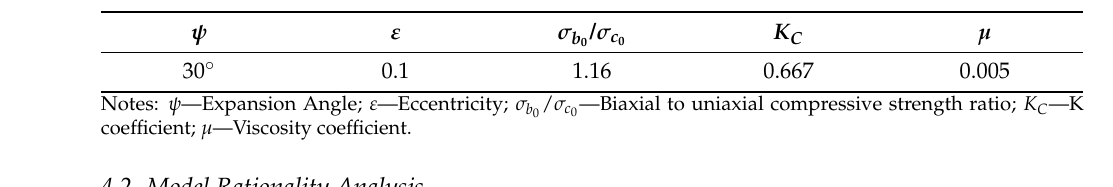
Figure 8. Unloading stiffness degradation curve under compressive tension of plastic damage model: ( a ) Degradation of unloading stiffness under pressure; ( b ) Degradation of unloading stiffness in the tensile state. Table 8. Failure criteria parameter table of ABAQUS concrete plastic damage model.